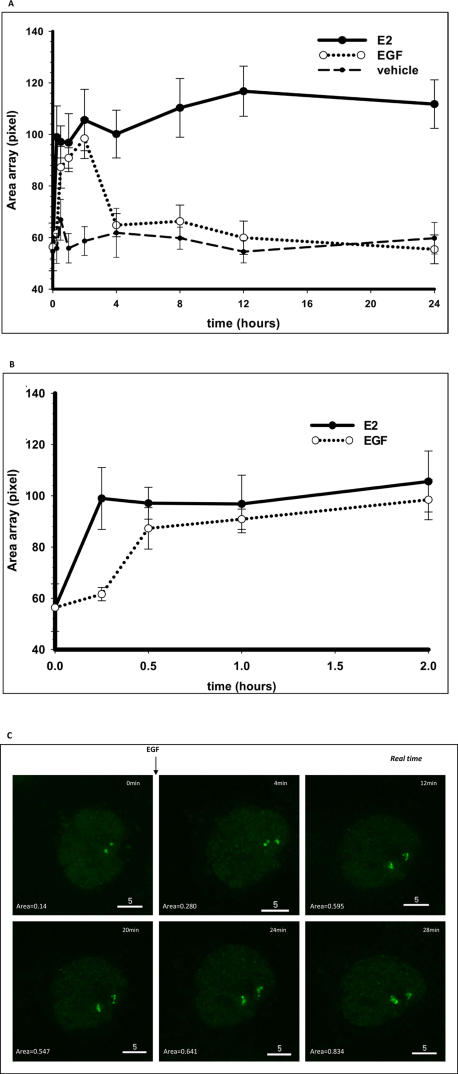
Large-scale chromatin decondensation of the PRL-array.A. PRL-HeLa cells expressing GFP-ER were treated for different times with ethanol (vehicle), E2 or EGF. After fixing and counterstaining with DAPI, cells were imaged and the array size was quantified using high throughput microscopy. B. This panel represents earlier time points to show the slower effect of EGF in inducing maximal decondensation of the array. Data represent the mean ±SEM of three different experiments. B. PRL-HeLa cells transiently expressing GFP-ER were imaged live at 37°C under constant perfusion of fresh medium (plus 100 ng/ml EGF after time 0). Image stacks were recorded every four minutes and are presented as projections. The value indicates the area of the array (µm2) shown in the image. Addition of EGF caused chromatin decondensation at the array within 30 minutes.